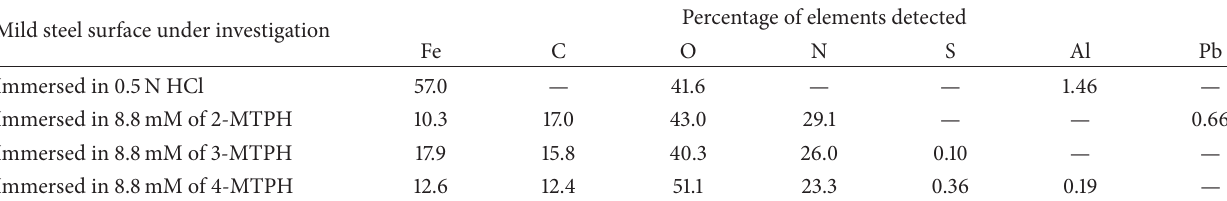
Table 7: Percentage of atomic contents of elements obtained from EDX spectra.